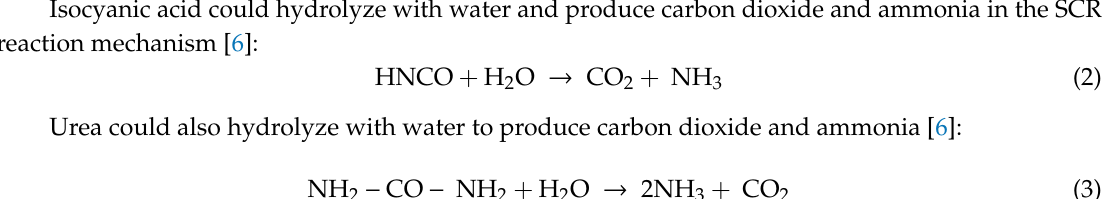
Figure 14. Visualization of the urea injection mechanism process.